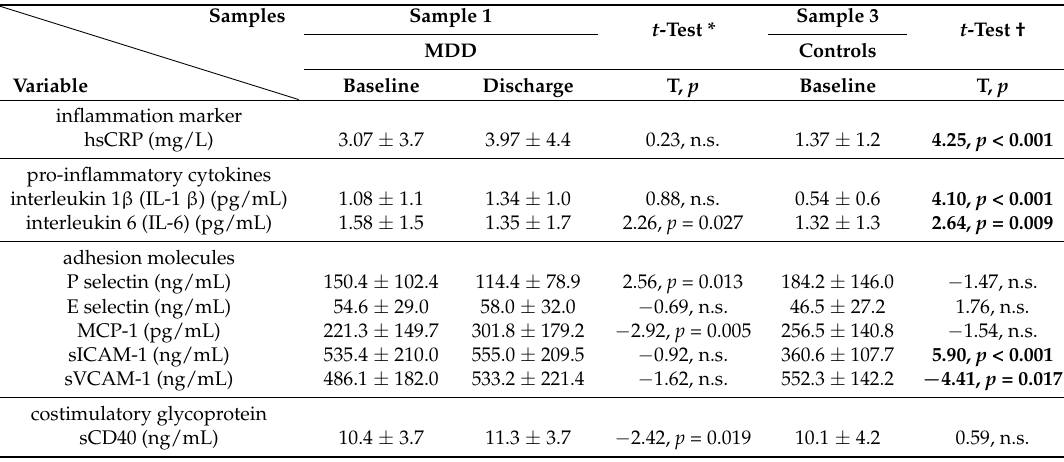
Table 2. Inflammation biomarkers and risk